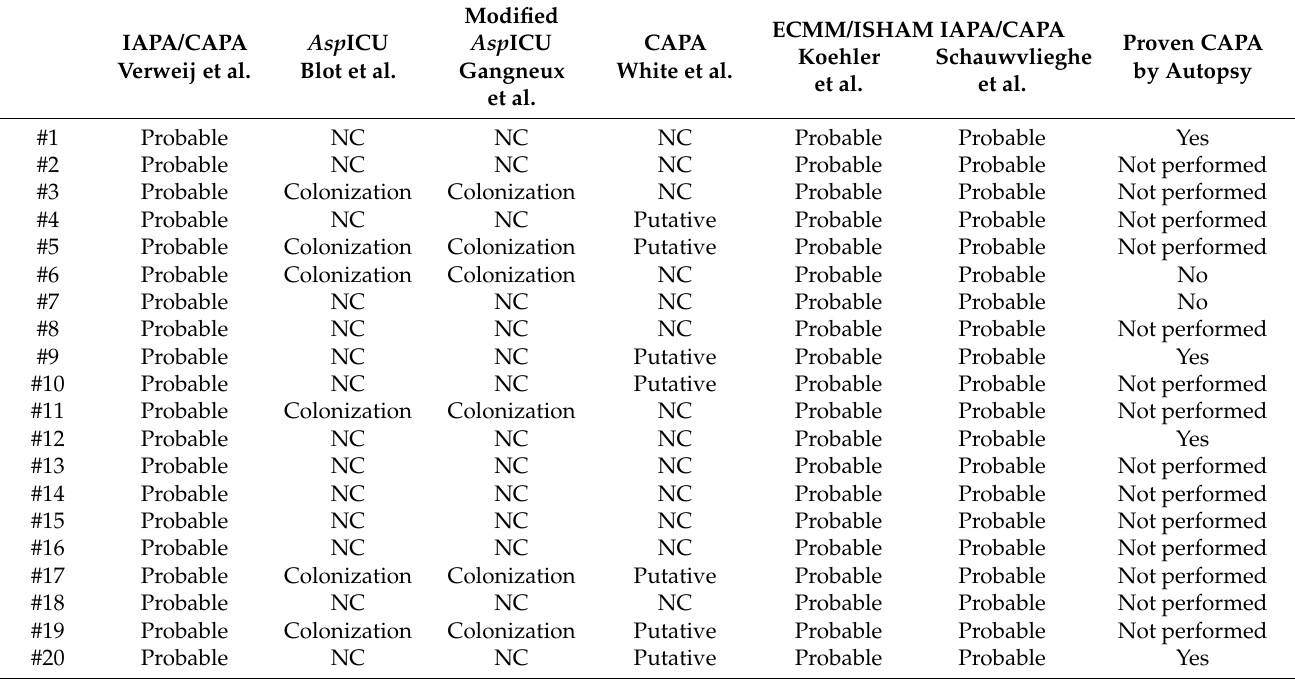
Table 3. Categorization of patients with CAPA according to the different proposed case definitions and